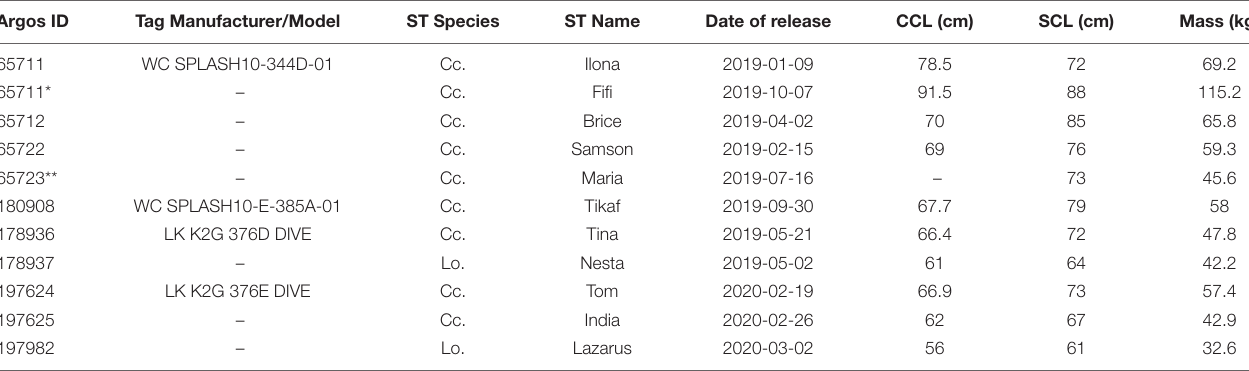
TABLE 1 | ST Morphometrics at release (Standard Carapace Length SCL, Curved Carapace Length CCL, body mass) and tracking parameters (Argos ID, tag manufacturer and model) for the 11 juvenile sea turtles released from Reunion Island (55.28 ◦ E; 21.15 ◦ S), Indian